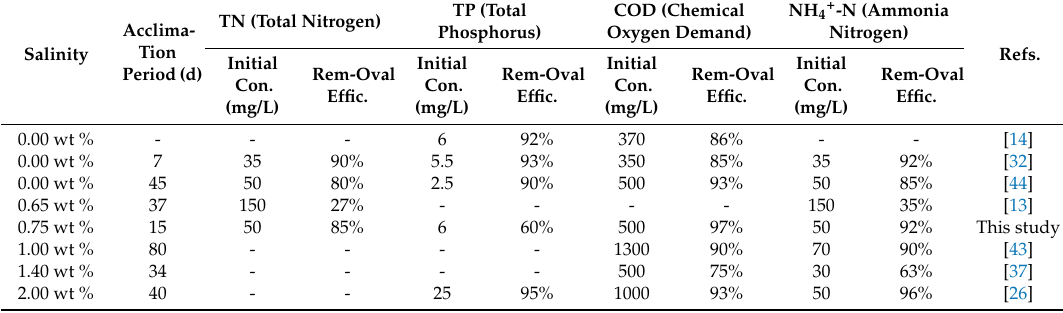
Table 2. Comparisons with other Biological Systems (Initial con. refers to initial concentration; Removal Effic. refers to removal efficiency of the pollutants; and Refs. refers to